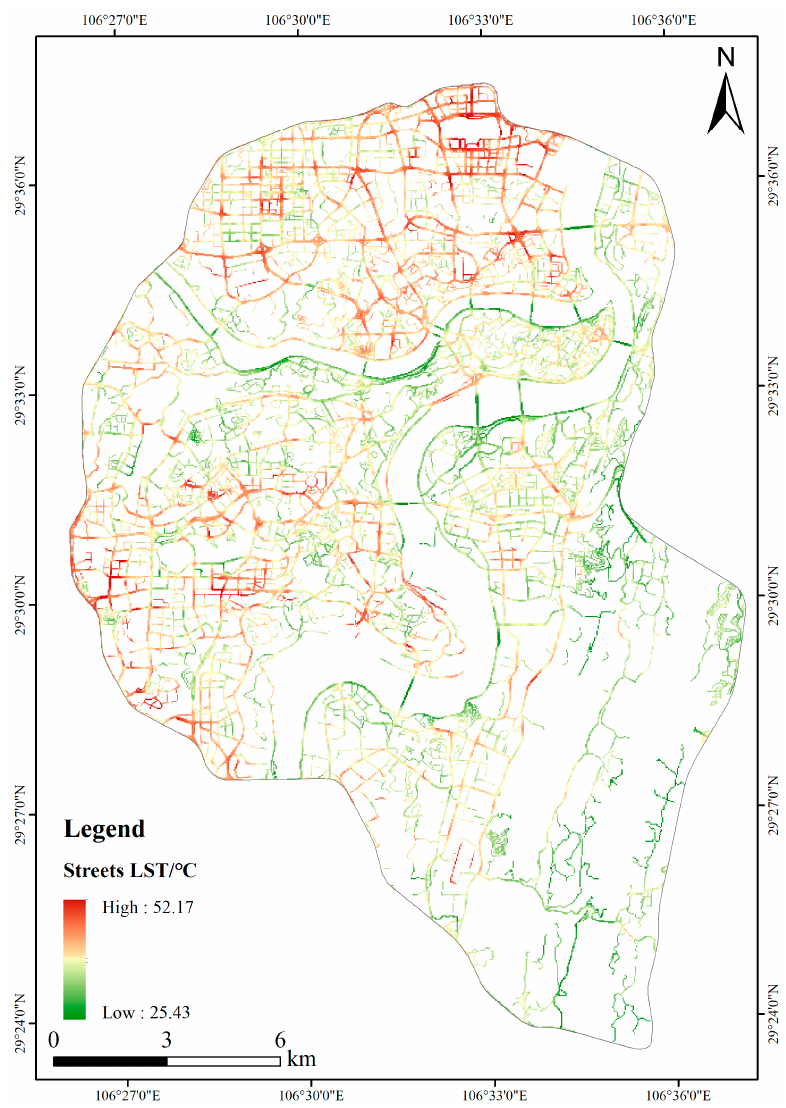
Figure 6. Spatial distribution map of streets LST.